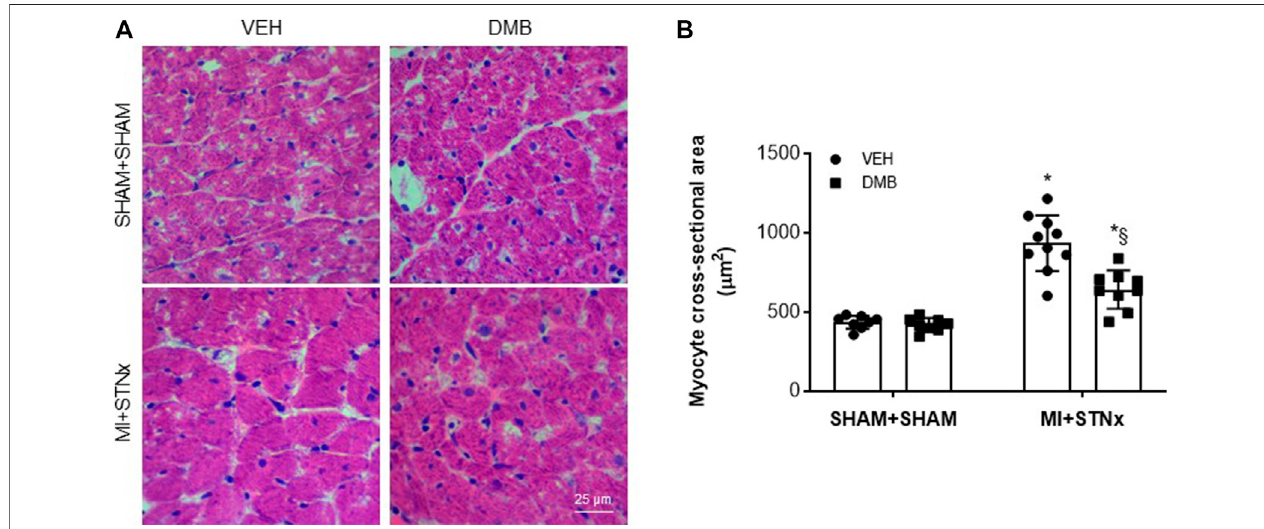
FIGURE 4| Representative hematoxylin eosin stainingof the heart sections. (A) and effects of CRS2 and DMB treatment on cardiac myocyte cross-sectional area (amarkerofmyocytehypertrophy)intheheart (B) .Dataareexpressedasmean ± SE( n (cid:1) 8 – 10foreachgroup).* p < 0.05vsSHAM+SHAM+VEH;§ p < 0.05,MI+STNx + DMB vs MI + STNx + VEH.